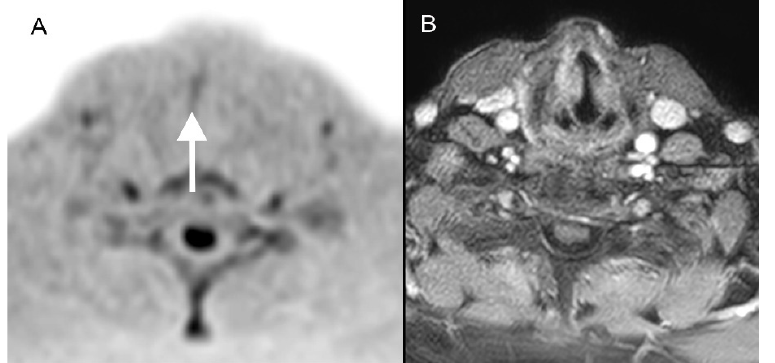
Figure 3. An 80-year-old patient with a pT1a cN0 cM0 squamous cell carcinoma of the vocal cord on the right side, which was diagnosed correctly in DWIBS (( A ); white arrow) by both readers but not in contrast-enhanced transversal T1-weighted scans with fat saturation ( B ).